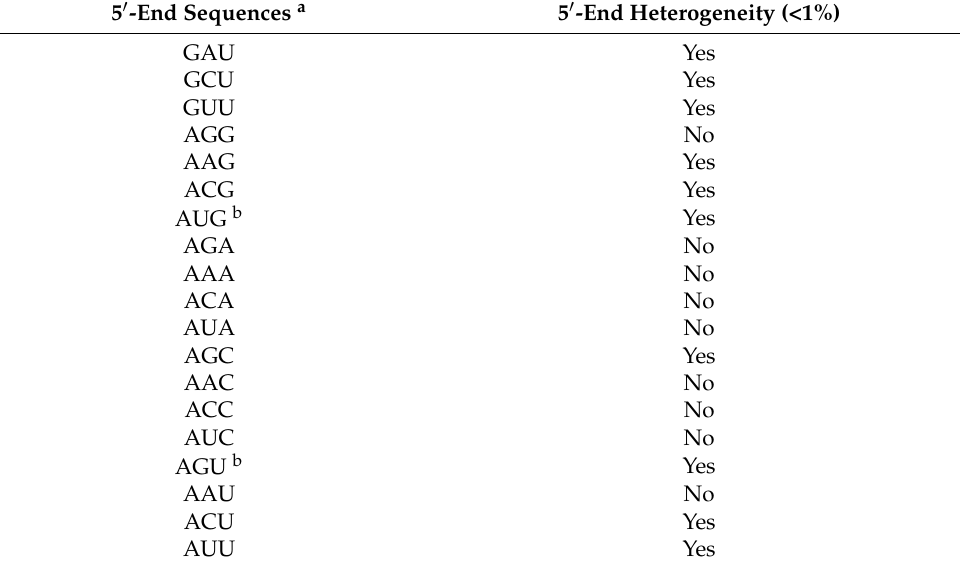
Table 4. Cont. 5 (cid:48) -End Sequences